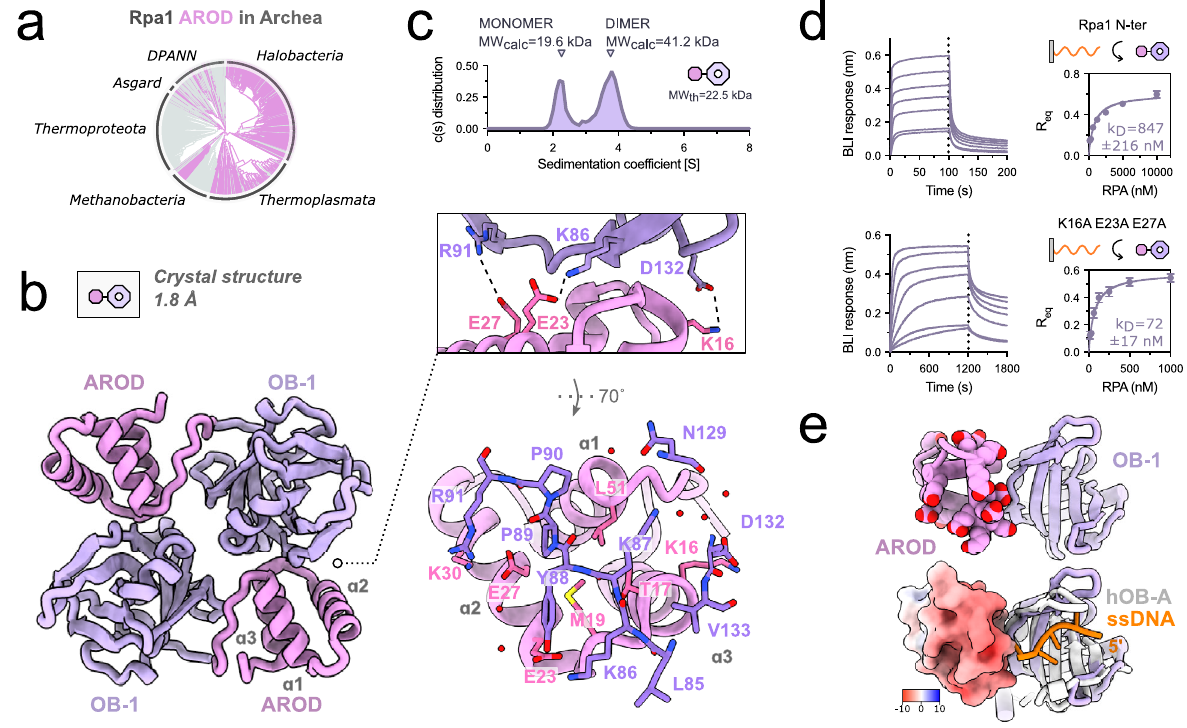
Fig. 5 | ssDNA binding by OB-1 is modulated by a Rpa1 acidic domain. a Phylogenetic analysis (bottom) reveals a broad distribution of Rpa1-AROD domain homologs across Archaea. Notably, in some members of the Thermo- plasmata, the AROD domain is found as a standalone domain rather than fused to Rpa1. Genomes lacking AROD domain are presented in gray. b High-resolution crystal structure of Rpa1 N-terminal domains at 1.8Å with a focused view on the AROD/OB-1 dimerization interface. c Sedimentation distribution pro fi le of Rpa1- AROD-OB-1 by sedimentation velocity. The theoretical (MWth) and calculated molecular weights (MWcalc) for each complex are given in kDa. d Speci fi c binding of WT (10, 5, 2.5, 1.25, 0.63, 0.31, 0.16 µ M; n =3) and mutant Rpa1 N-terminal